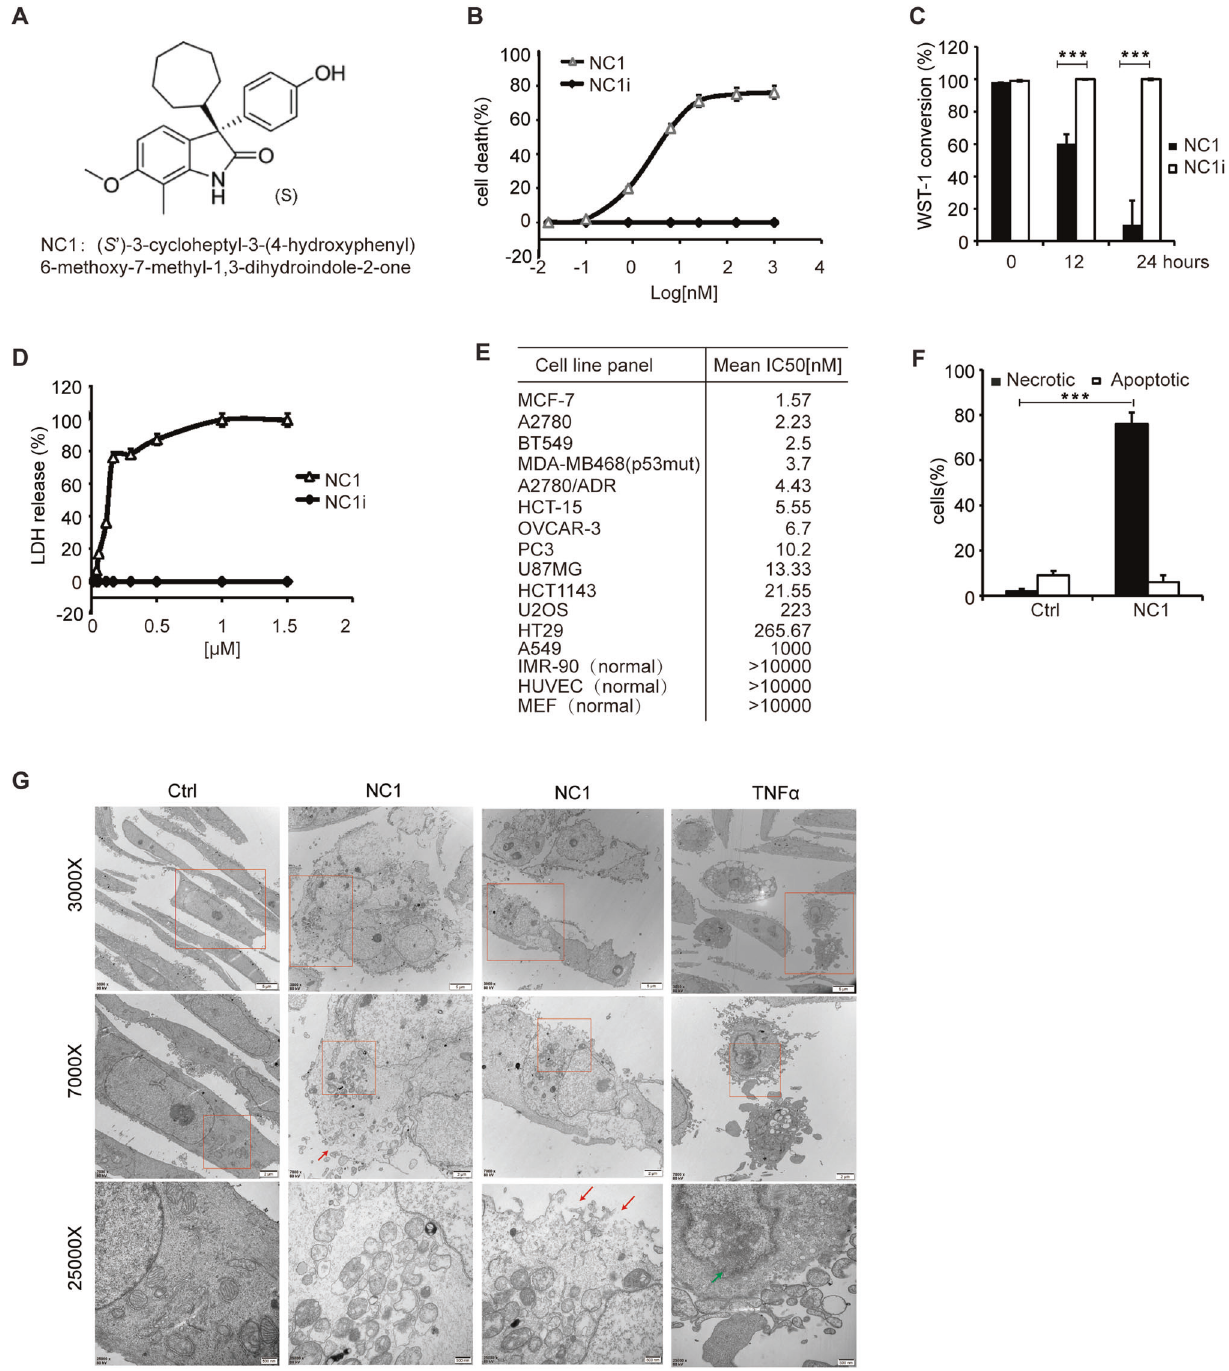
Fig. 1 NC1 induces regulated necrosis in human cancer cells. A Chemical structure of necrocide 1 (NC1, ( S ’ )-3-cycloheptyl-3-(4- hydroxyphenyl)6-methoxy-7-methyl-1,3-dihydroindole-2-one, the active stereoisomer). B Dose-dependent killing of MCF-7 breast cancer cells by NC1 but not by its inactive stereoisomer (NC1i). Conversion of the tetrazolium salt WST1 was measured by colorimetry 24 h after the addition of the indicated concentrations of either NC1 or NC1i to measure cell death. C Time-dependent killing of MCF-7 cells by NC1 but not by NC1i, as determined 12 or 24 h after the exposure of cells to 10 nM NC1 by WST1 conversion assays. D Dose-dependent killing of MCF-7 cells by NC1 but not by NC1i, as determined by the release of lactate dehydrogenase (LDH) into the culture supernatant. E IC 50 values of NC1 on a panel of different human cancer cell lines, normal cells and mouse embryonic fi broblast (MEF), as determined by WST1 conversion assay 24 h after addition of the compound to the cells. F , G Effects of NC1 on cellular ultrastructure. MCF-7 cells exposed to NC1 were examined by transmission electron microscopy (scale bars = 500 nm/2 µm/5 µm as indicated). Red arrows indicate membrane rupture. Green arrows indicate chromatin condensation. Percentage of MCF-7 cells with an apoptotic or necrotic appearance as shown in ( F ). Values are means ± standard deviation of n = 3 independent determinations. Asterisks indicate signi fi cance between the two groups indicated (* p < 0.05; ** p < 0.01, ** p < 0.001).